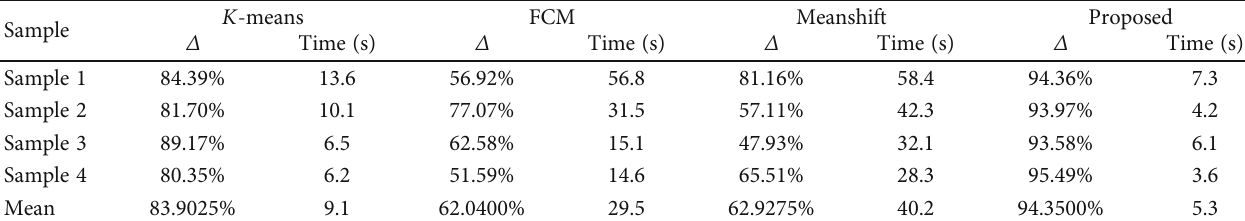
Table 5: Comparison of the accuracy and running time of COT segmentation of several di ff erent clustering algorithms.